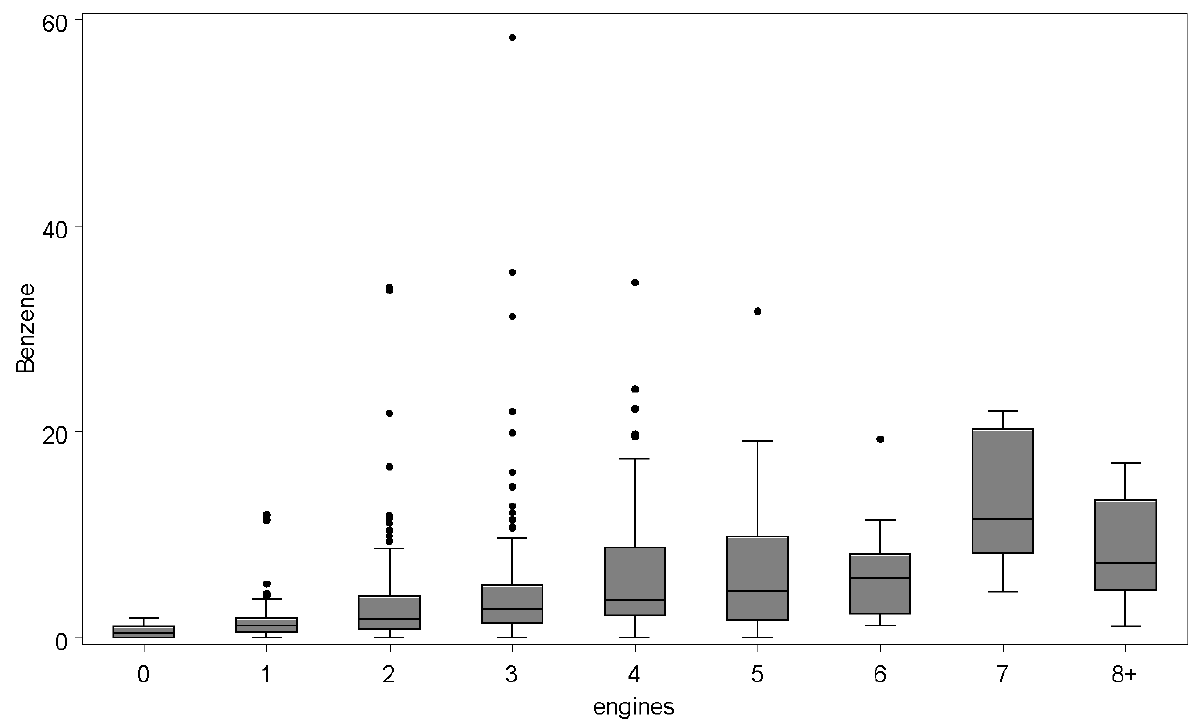
Figure 2. Benzene levels in ppb vs. total number of engines kept in the